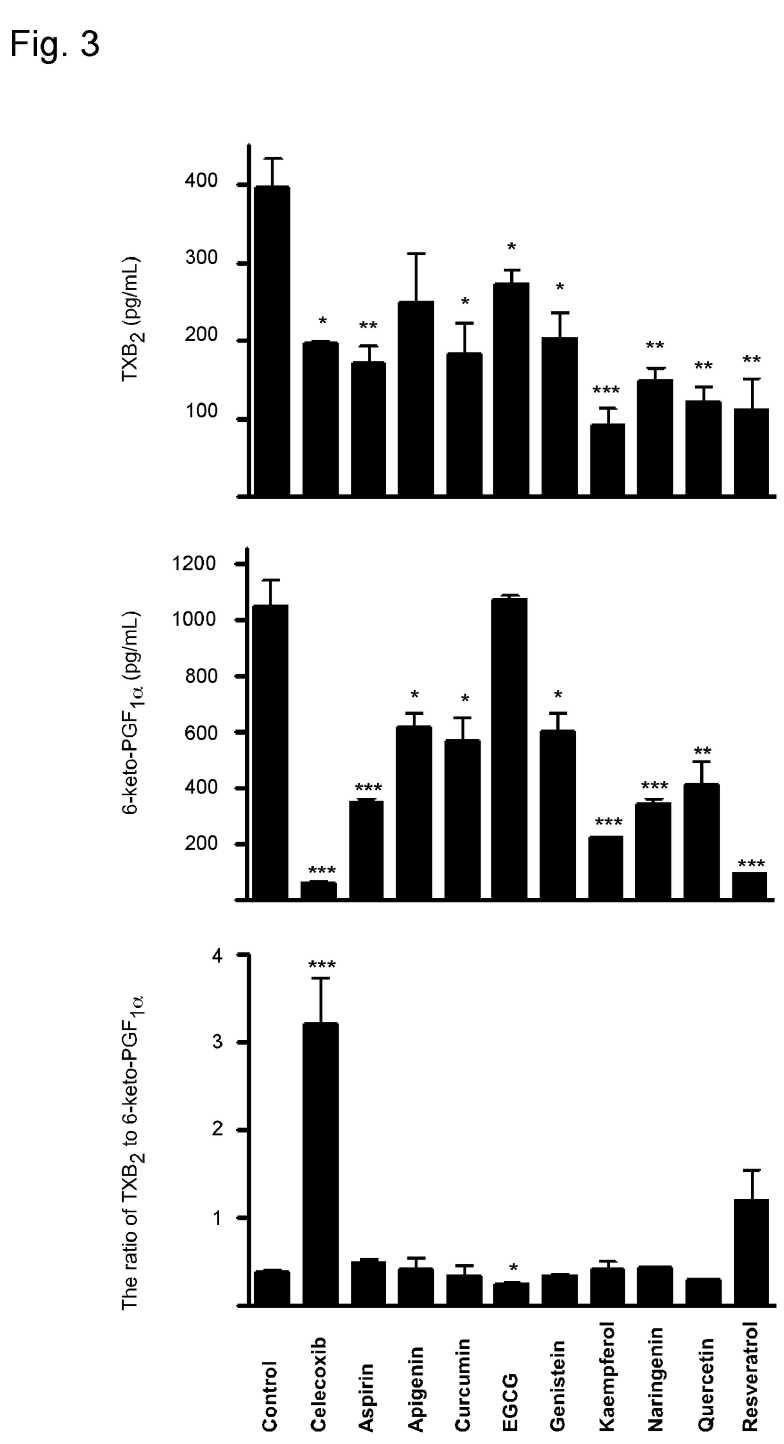
Figure 3. Effects of dietary phytochemicals on (A) TXB and (B) 6-keto-PGF α under pro-inflammatory 2 1 conditions. HUVECs were seeded in a six-well-plate (6×10 5 cells per well). At 70-80% confluence, cells were pretreated with 1 mL fresh medium containing DMSO or 3 µM of each individual compound for 2 h and then IL-1β (17.5 ng/mL) was added together with each individual compound for another 8 h incubation. Supernatant fractions were collected for prostaglandin measurement. (C) The ratio of TXB /6-keto-PGF α. Data are presented as means ± S.E.M. (n = 4) and the asterisk(s) indicate a significant (*, p < 0.05; **, p 2 1 < 0.01; ***, p < 0.001) difference versus Group 1 (IL-1β). doi: 10.1371/journal.pone.0076452.g003 PLOS ONE |